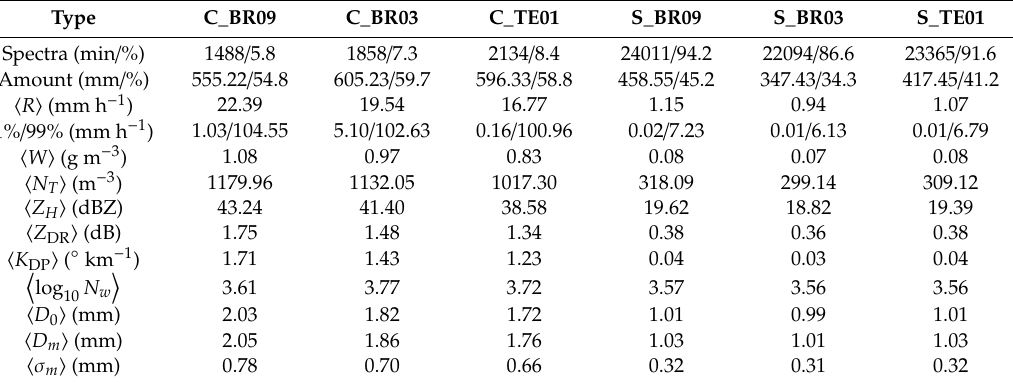
Table 2. Properties of DSDs for di ff erent rain-type classification